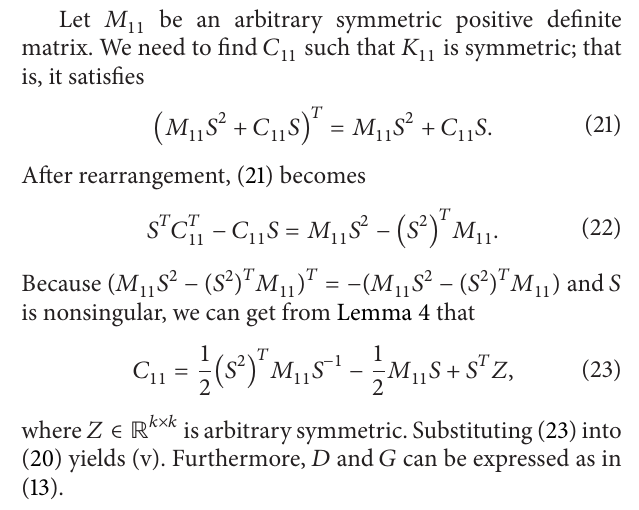
Algorithm 9. An algorithm for solving Problem 1 is